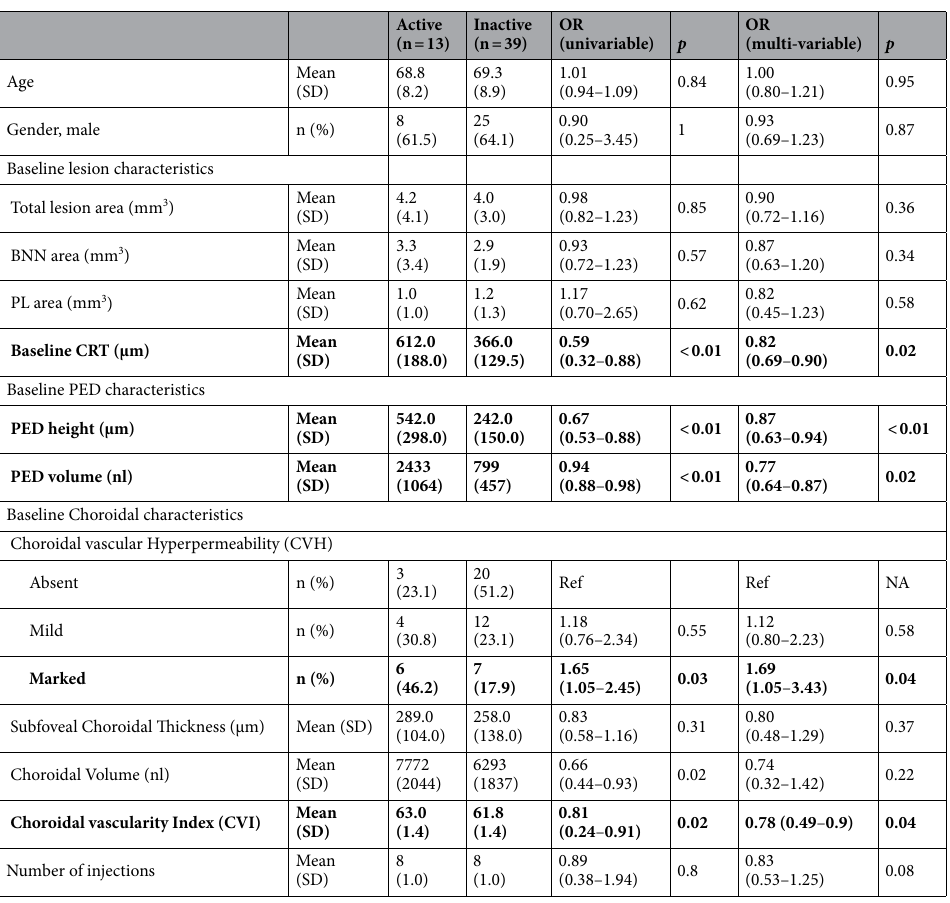
Table 3. Linear regression analysis of baseline characteristics against disease activity status at month 12. BNN Branching neovascular network, PL polypoidal lesion, CRT central retinal thickness, PED pigment epithelium detachment, CVH choroidal vascular hyper-permeability; CVH defined as marked = presence of patchy hyper fluorescence with blurred margins persisting from the mid to the late phase ICGA, mild = fuzziness of choroidal vessels in mid-phase ICGA but no patchy hyper fluorescence in late phase, absent = none of the above features present, CV choroidal volume, CVI choroidal vascularity index. Multivariate analysis adjusted for age, sex and total number of injections. Bold fonts denote parameters significantly influencing the disease activity at month 12 from baseline and are retained in the final multivariable